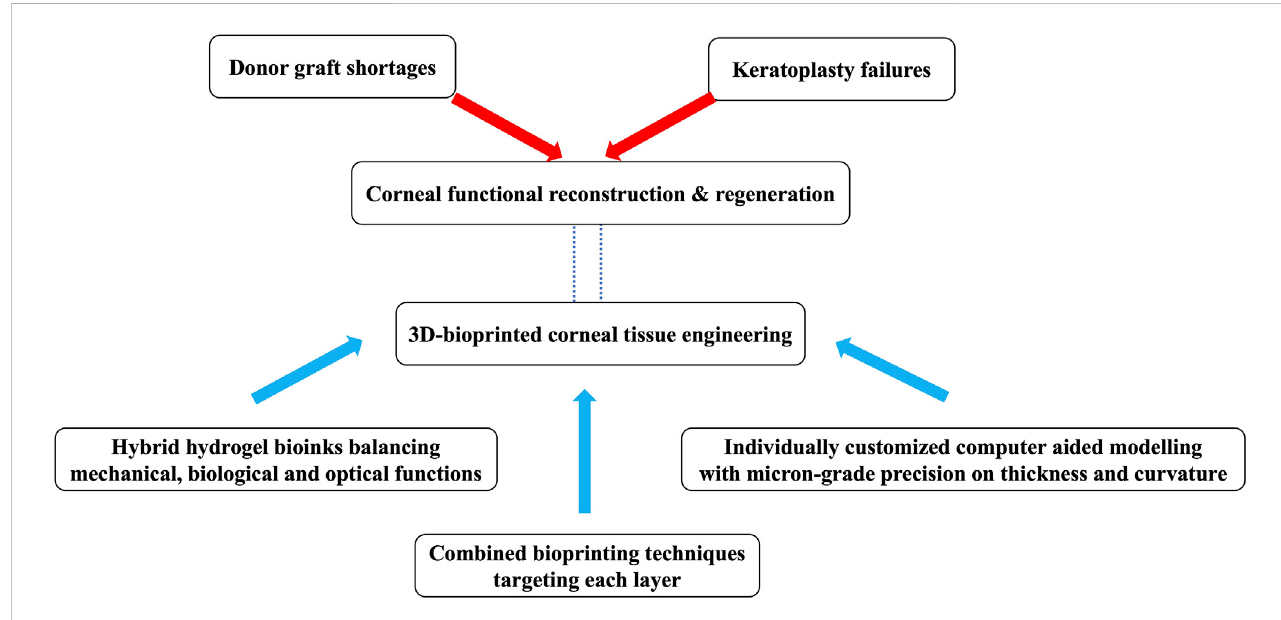
FIGURE 7 Take-home schematic